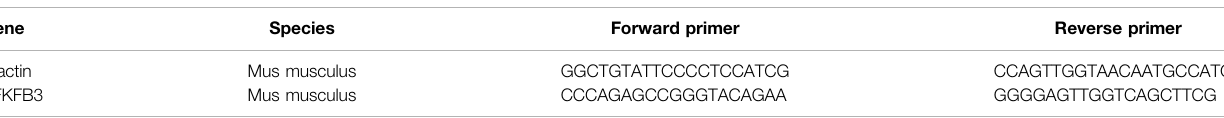
TABLE 1 | List of primer sequences used in this study.